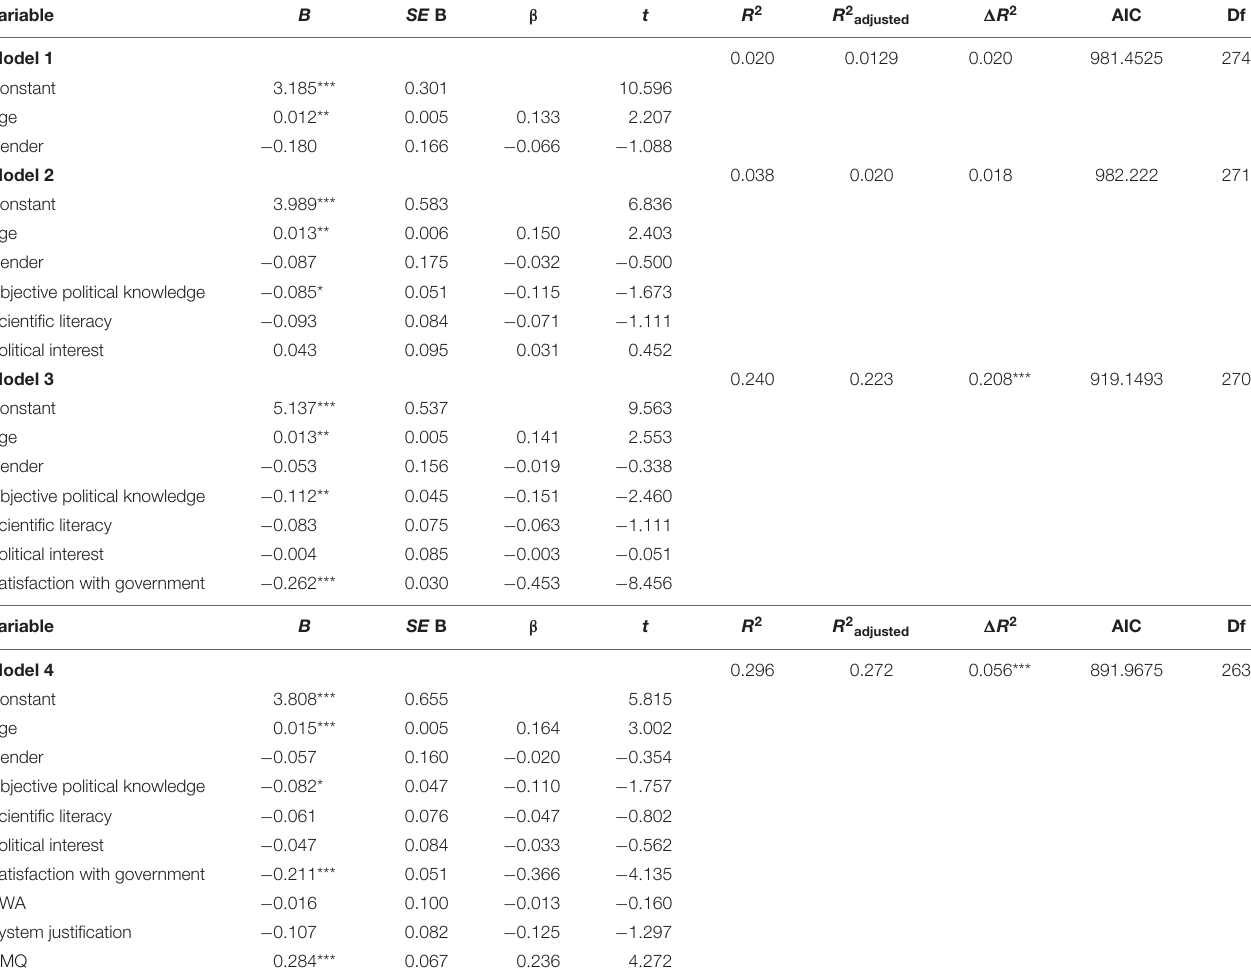
TABLE 3 | Hierarchical regression results for belief in anti-government fake